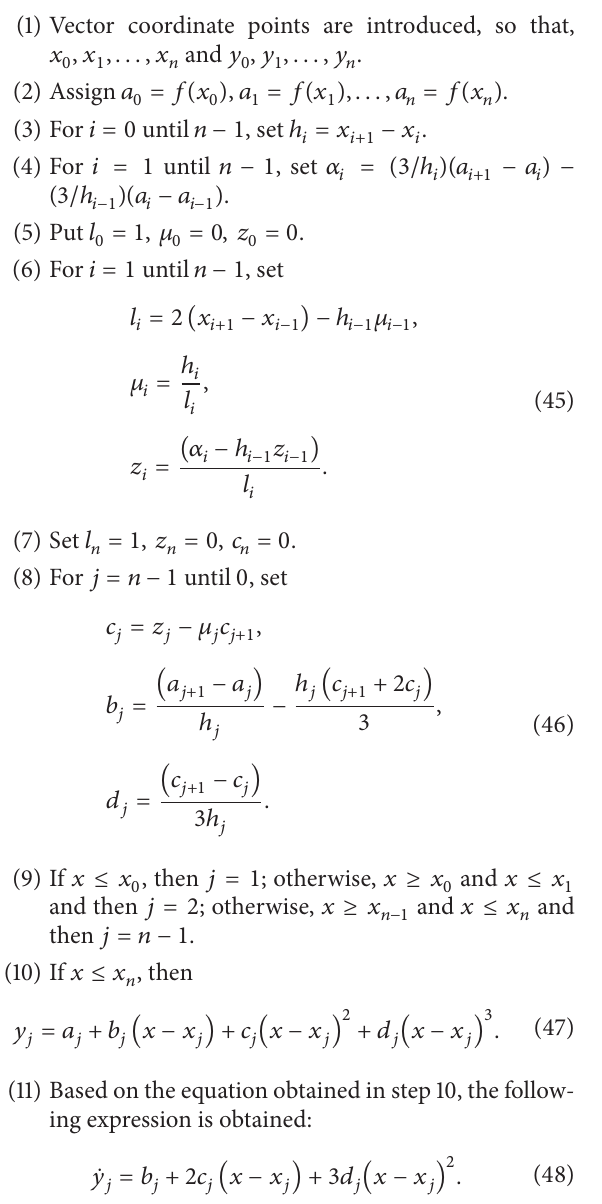
Algorithm 1. In order to build the cubic interpolation func- tion (43), according to [21], there must be defined the number of points 𝑛 which satisfy the following condition: 𝑥 0 < 𝑥 1 < ̈𝑆(𝑥 ) = ̈𝑆(𝑥 ) = 0 . The following steps are ⋅ ⋅ ⋅ < 𝑥 𝑛 with 0 𝑛 ∗ , 𝑦 ∗ , 𝜑 ∗ ) suggested to generate (𝑥